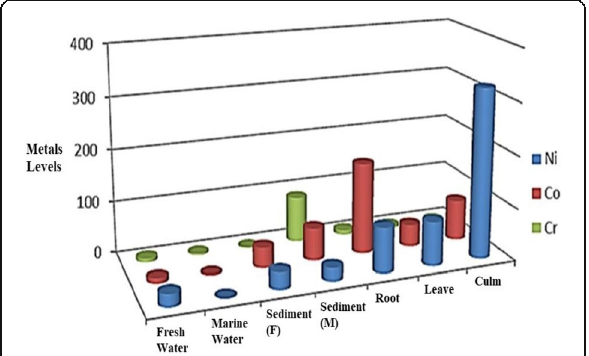
Fig. 4 Mean concentrations of heavy metals ( μ g L − 1 and μ g g − 1 ) within different environmental components